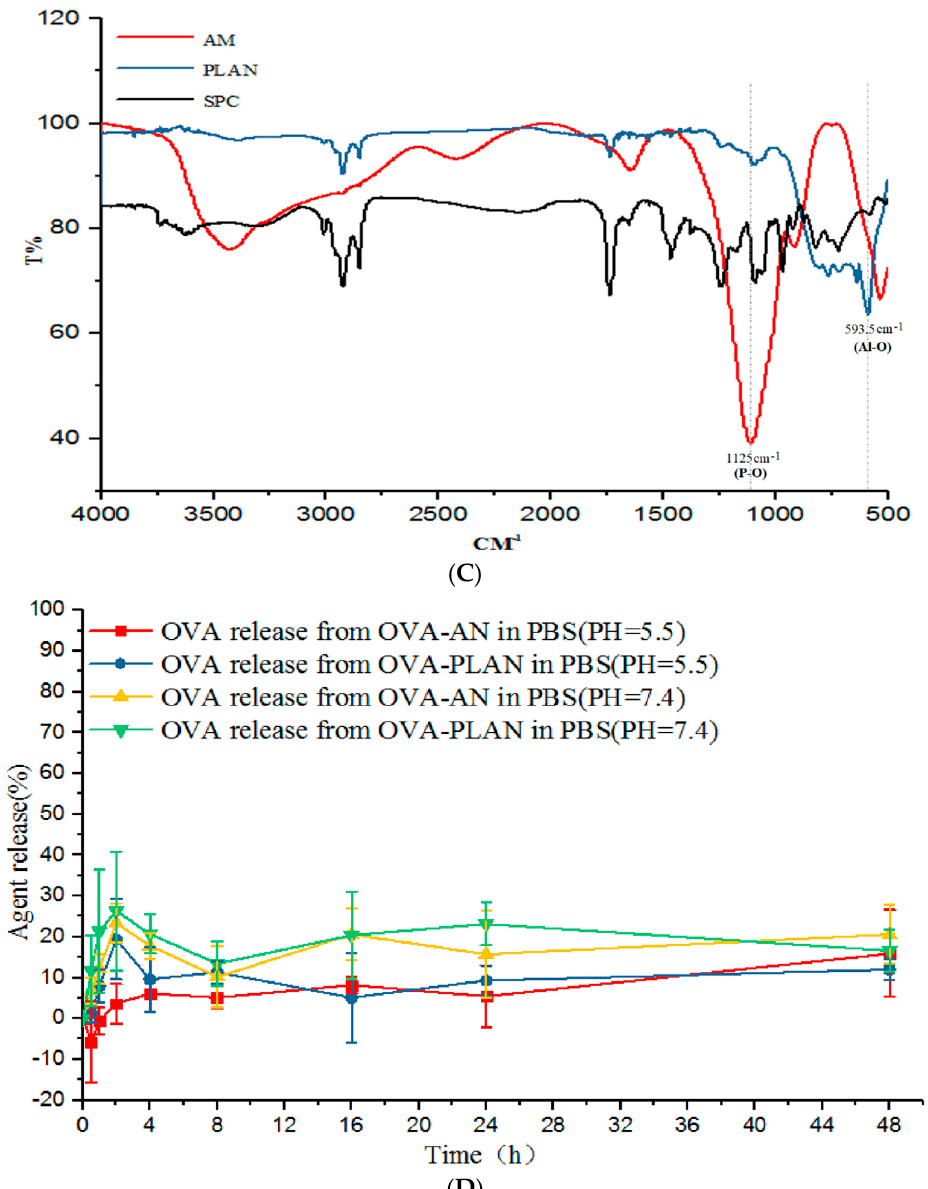
Figure 1. Features of the prepared Al-nanocarriers. ( A ) Transmission electron microscope (TEM) image of phospholipid bilayer-coated aluminum oxide nanoparticles (PLANs) displays the spherical shape and a size of 30 nm of the Al-nanocarriers (the inserted panel showing phospholipid coatings with thickness of around 5 nm observed with uranyl acetate negative staining). ( B ) TEM image of PEG-PLANs displays the spherical shape and a size of 30 nm of the Al-nanocarriers (the inserted panel showing phospholipid coatings with thickness of around 10 nm observed with uranyl acetate negative staining and the inexplicable presence of certain nano-sticks). ( C ) Fourier transform infrared spectroscopy (FTIR) spectra of aluminum microparticles (AMs) of Al(PO 4 ) 3 , 1,2-dipalmitoyl-sn-glycero-3-phosphocholine (DPPC), and PLANs indicate, by comparative analysis, formation of covalent bonds between phosphate group and Al, as evidenced by a characteristic peak at ~1125 cm − 1 which is resulted from the vibrations of Al–O–P. ( D ) Ovalbumin (OVA) release curves of the Al-based nanocarriers in different media at 37 °C showing trivial cargo release from these carriers ( n = 3).